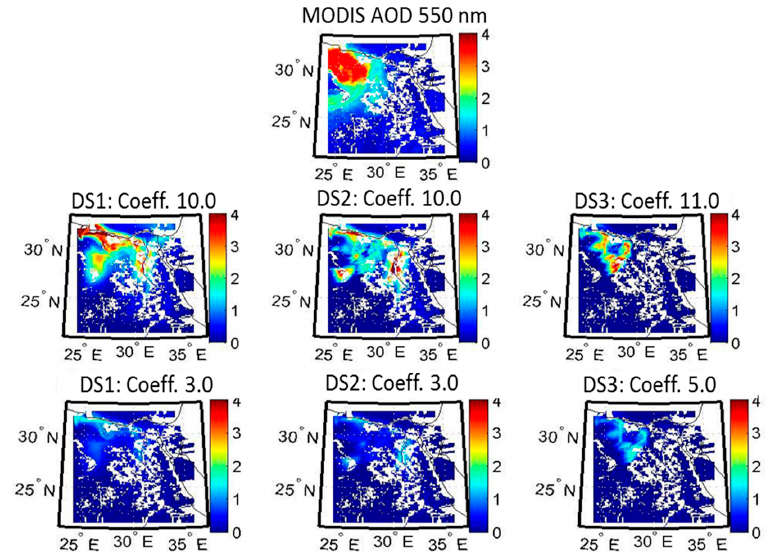
Figure 11. The Spatial distribution of AOD from using the shown selected DS and tuning coefficients over Egypt on the day of the dust storm of 31 March 2013.